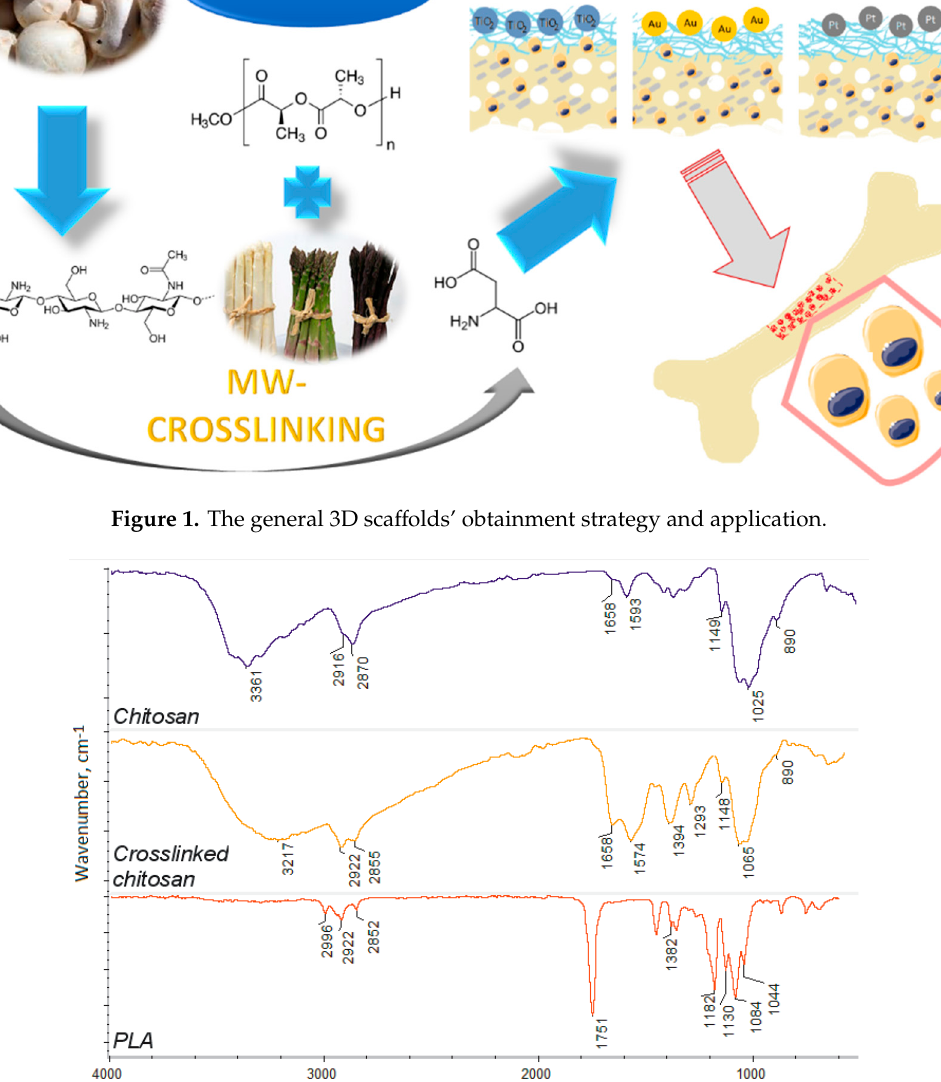
Figure 2. FT-IR spectra of the pure chitosan, crosslinked chitosan, and poly (lactic acid) nanofibers.